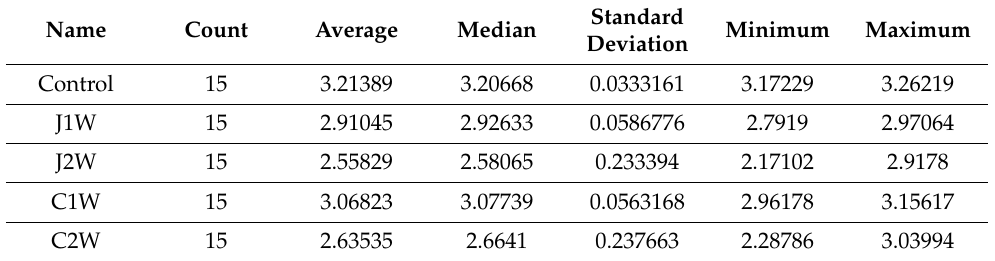
Table 3. Summary statistics for entropy.